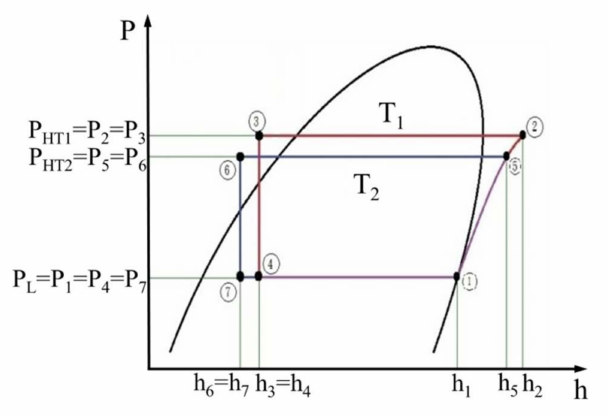
Figure 5. Mollier Chart refrigeration cycle for the water